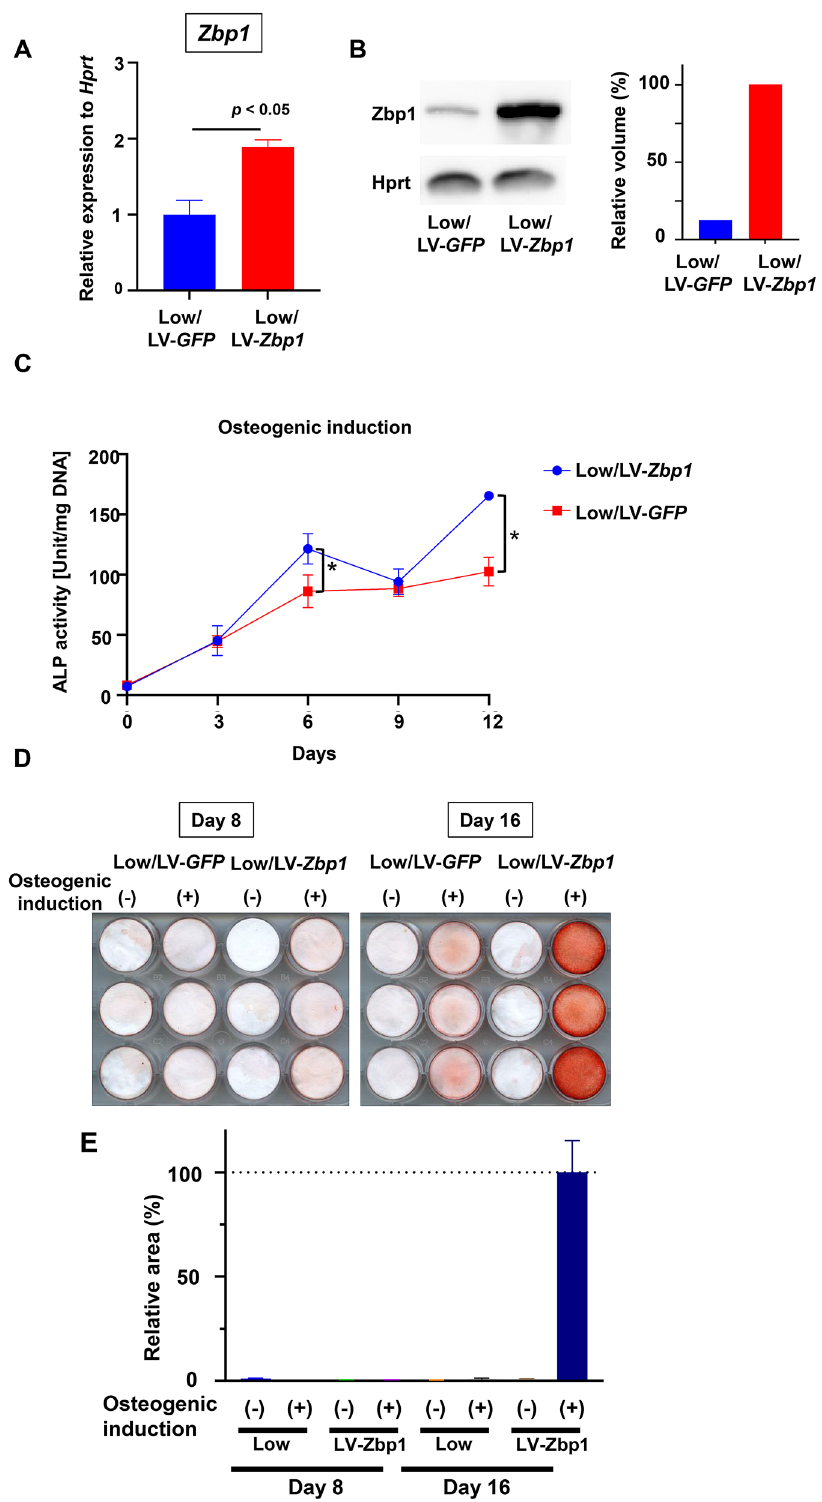
Figure 5. The effects of Zbp1 overexpression on the osteogenic differentiation of murine periodontal ligament (PDL) cells. ( A ) Zbp1 mRNA expression was analyzed by quantitative reverse transcription-polymerase chain reaction (n = 3 wells). ( B ) Western blotting using anti-Zbp1 and anti-Hprt antibodies is shown. The original image is included in Supplementary Figure S6. The quantification of the band volume was performed. Each value was normalized to the value of the control sample. ( C ) Low/LV-Zbp1 and Low/LV-GFP were cultured in osteogenic medium, and their ALP activity was measured on days 0, 3, 6, 9, and 12 of differentiation induction (n = 3 wells). The results of the analysis are shown as the mean ± standard error. ( D ) Low/LV-Zbp1 and Low/LV-GFP were cultured in osteogenic medium, and differentiation was induced on days 8 and 16. The experiments were performed in triplicate (n = 3 wells) for each group. ( E ) The quantification of Alizarin staining area performed. Each value was normalized to the value of osteogenic induction on day 16 of the Low/LV-Zbp1. Statistical analysis was performed using GraphPad Prism v9.0.2 (www. graph pad. com). The area analysis was performed by ImageJ software v1.53c